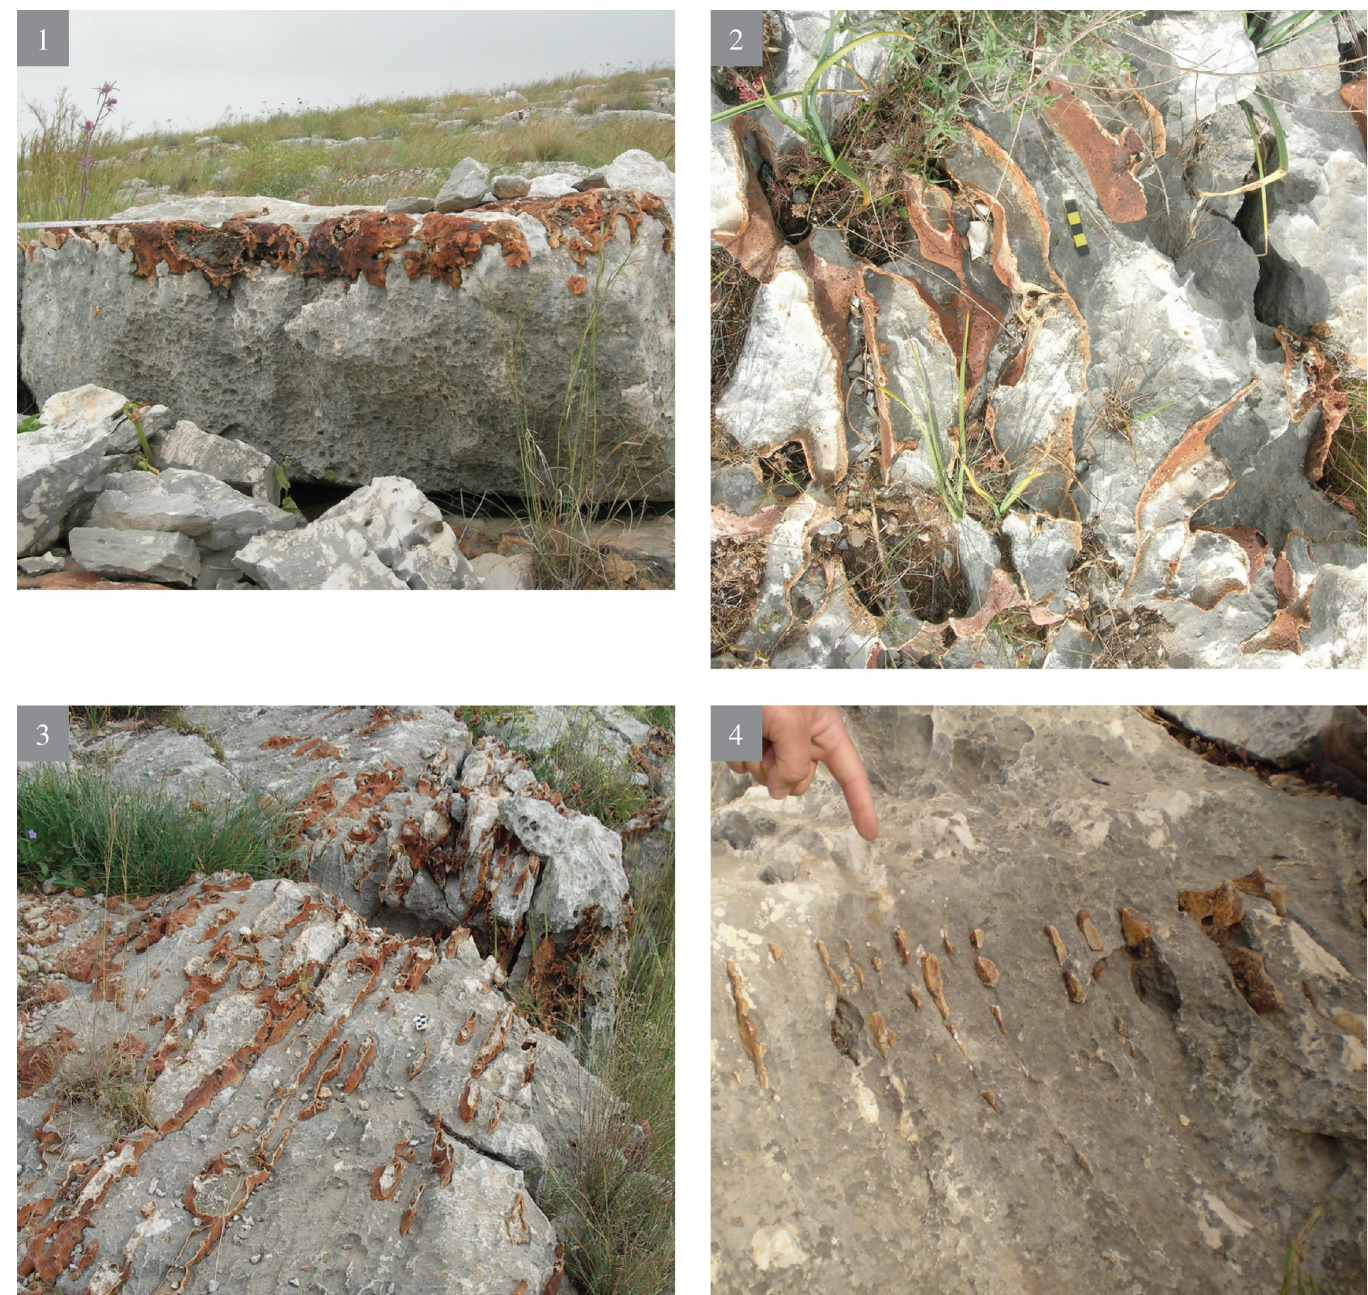
Fig 2. Bi’na formation—appearance and morphology